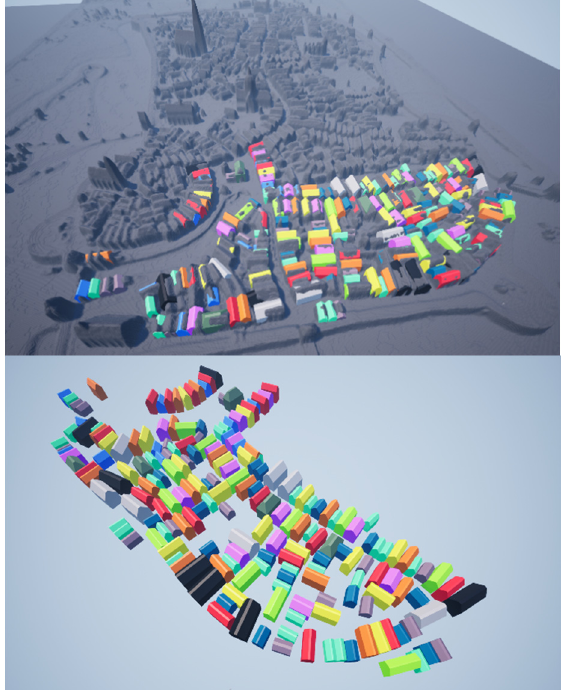
Figure 5. Screenshots from the Unreal Engine editor window showing the first stage of the process: the placement of low- poly meshes into the scene, guided by height map generated from photogrammetry mesh (top). The different coloured meshes each represent different variations of townhouse (bottom).